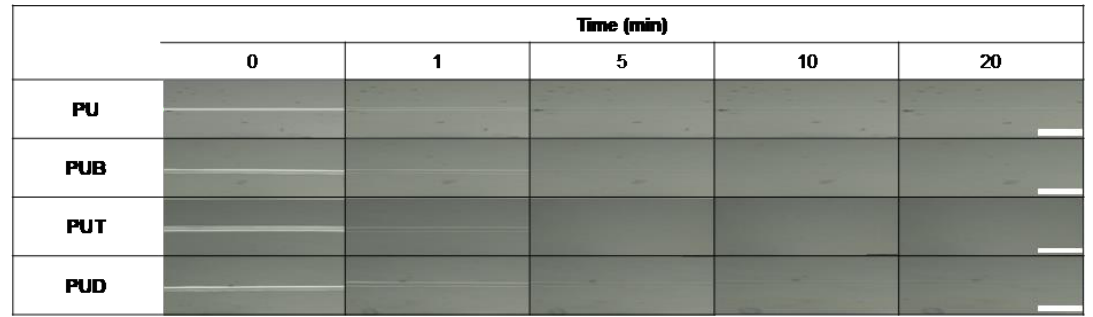
Figure 1. Optical microscope images of PU, PUB, PUT, and PUD before and after the self-healing process. The loading force of 3 N was equally applied to all the samples and the self-healing temperature was set to be T g + 10 °C . The scale bar is 100 µm.